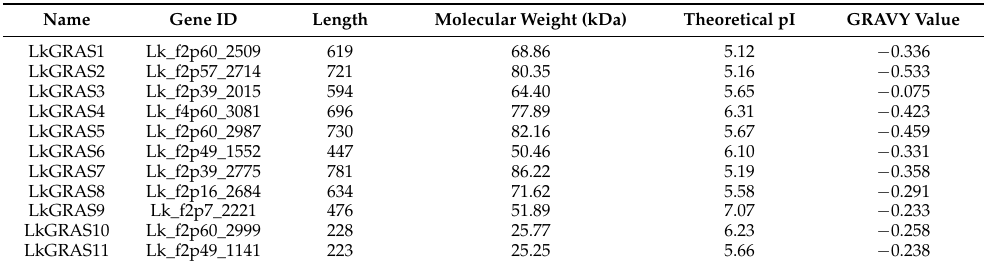
Table 1. Basic information of L. kaempferi GRAS family members.